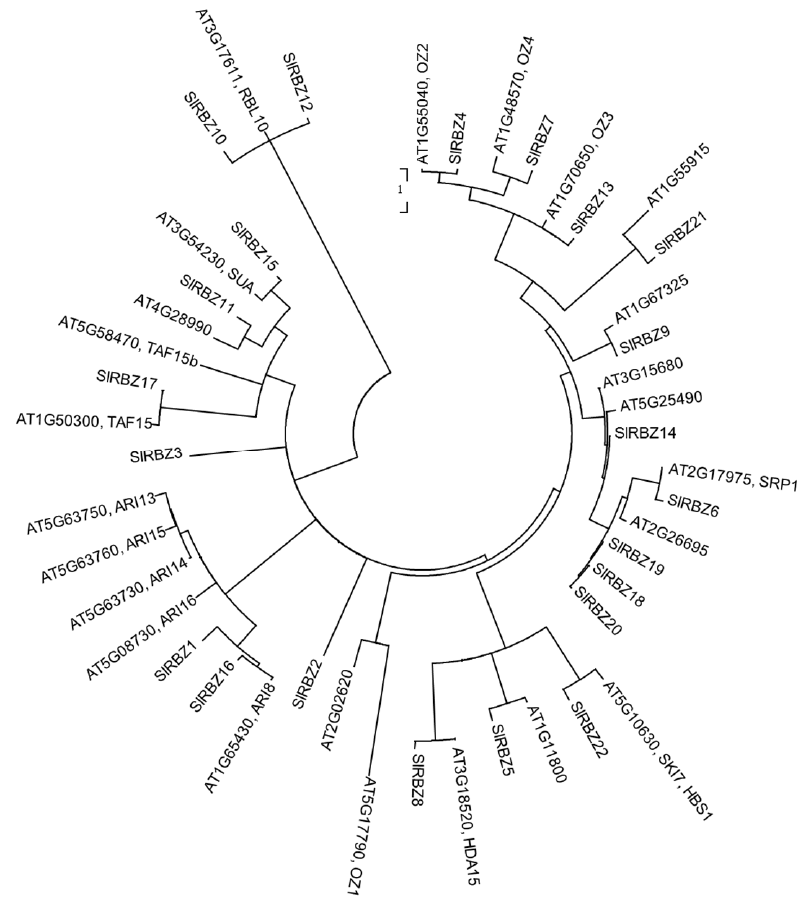
Figure 2. Phylogenetic tree of 46 RBZ genes from tomato and Arabidopsis . The SlRBZ genes were unevenly distributed on 8 of the 12 tomato chromosomes (Figure 3). The number of SlRBZ genes appearing on each chromosome had a wide range. There were five SlRBZ genes on Chromosome 12 and four SlRBZ genes on Chromosome 1. Three SlRBZ genes were located on Chromosomes 3, 5 and 8, respectively, while there were two on Chromosome 11 and one on Chromosomes 2 and 7, respectively. Two gene pairs (SlRBZ1/16 and SlRBZ10/12 ) dispersed in the genome were identified as being involved in segmental duplication events. This trend suggests that segmental duplication, rather than tandem duplication, contributes to the expansion of the SlRBZ genes in